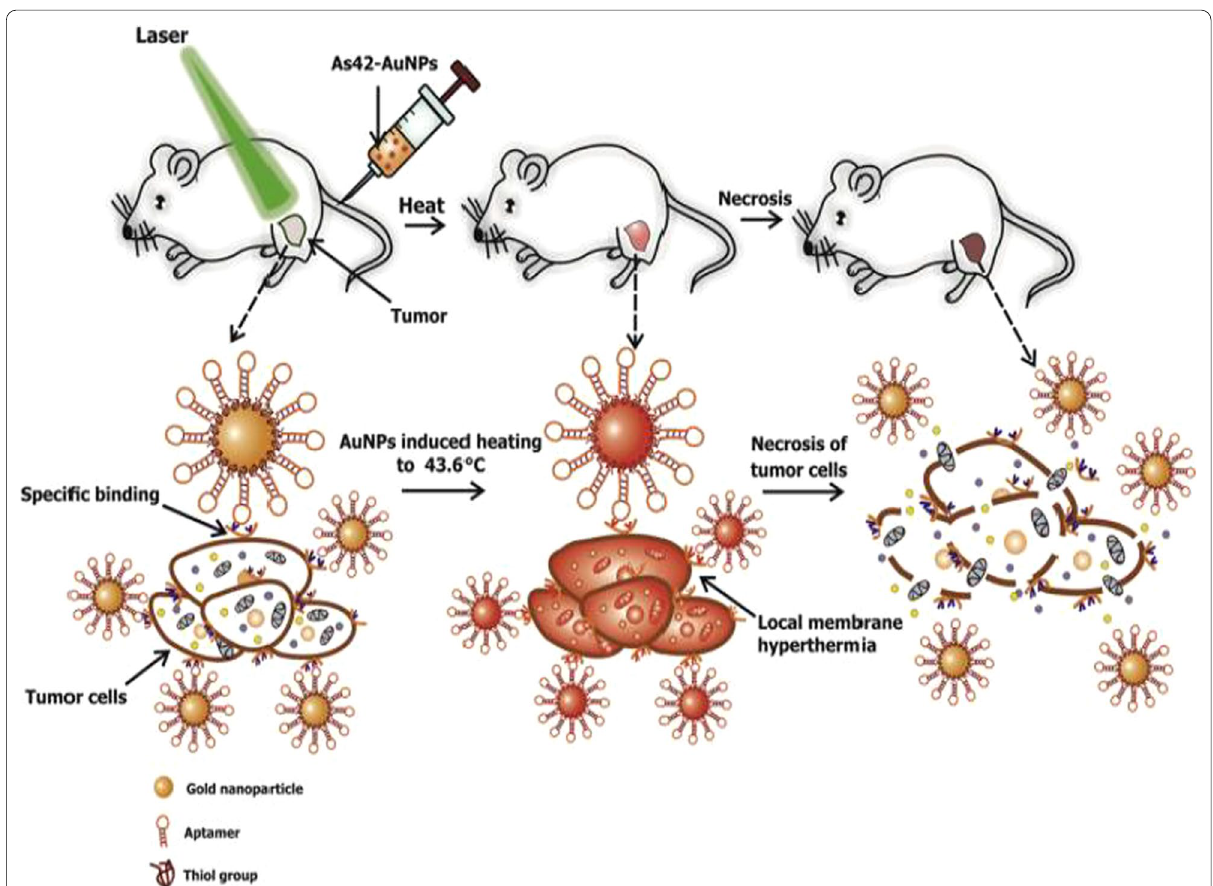
Fig. 9 In vivo plasmonic PT therapy of cancer cells using targeted AuNSs. As42-AuNPs localized in HSPA8-expressing tumor cells after i.v injection. Exposure to laser treatment resulted in hyperthermia that caused cancer cell death. Reproduced with permission [163]. Copyright 2017,